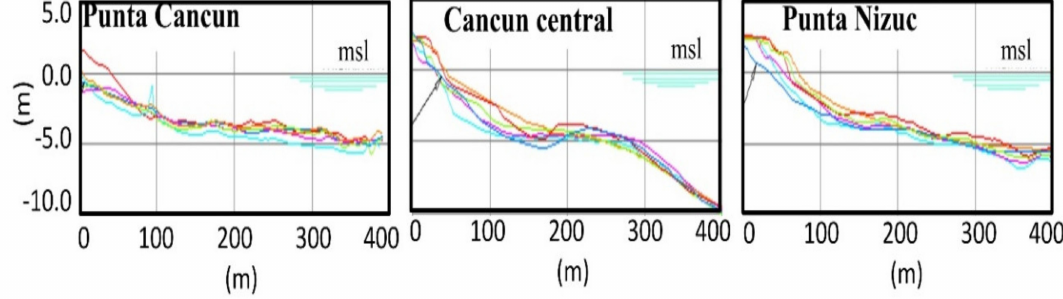
Figure 11. Beach profiles at northern (P. Cancun); central, and southern (P. Nizuc) Cancun, showing the beach growth due to the first beach fill (early 2006), and a return to erosion conditions by 2008, when the need for a 2nd nourishment was evident: Nov-2005 ( −− ), May-2006 ( −− ), Aug-2006 ( −− ), Apr-2007 ( −− ), Sep-2007 ( −− ) and Aug-2008 ( −−